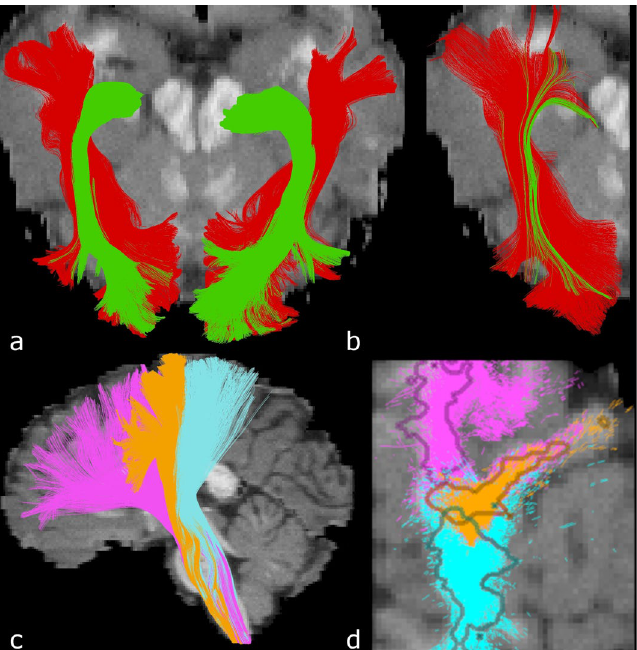
Figure 2. Erroneous bundle segmentation examples. ( a ) ILF (red) and OR (green) with ( b ) an example of sub-optimal bundle segmentation in submission 1.3 (using Recobundles). ( c ) FPT (pink), CST (orange), and POPT (blue), with ( d ) streamlines recovered for these bundles from all 2015 submissions. The GT bundle mask borders are shown in a darker contour. We can see that classification was sometimes arbitrary to one or the other bundle, particularly in the center.